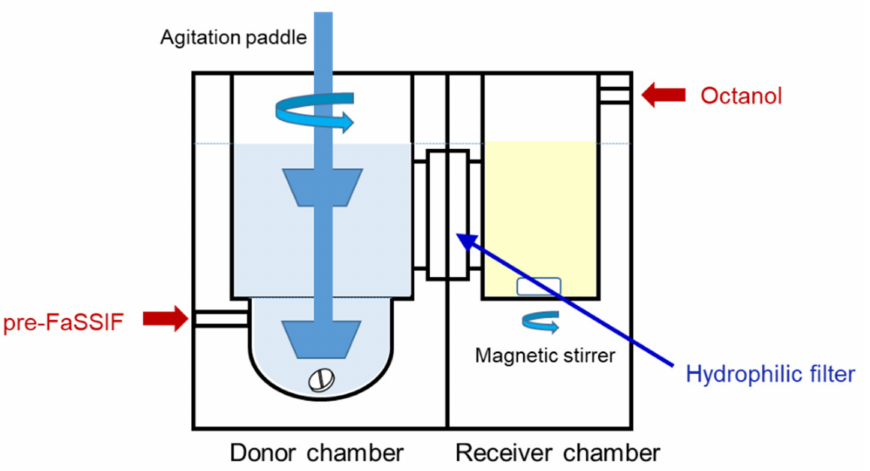
Figure 1. Schematic illustration of the BE checker.